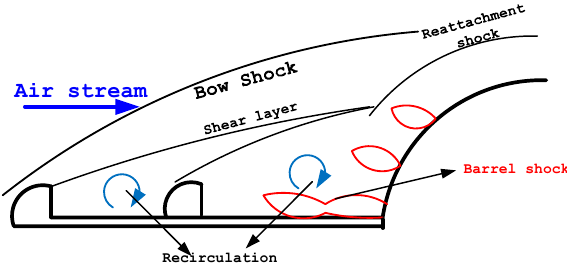
Figure 1. Schematic of multi-jets system for cooling of nose cone with double